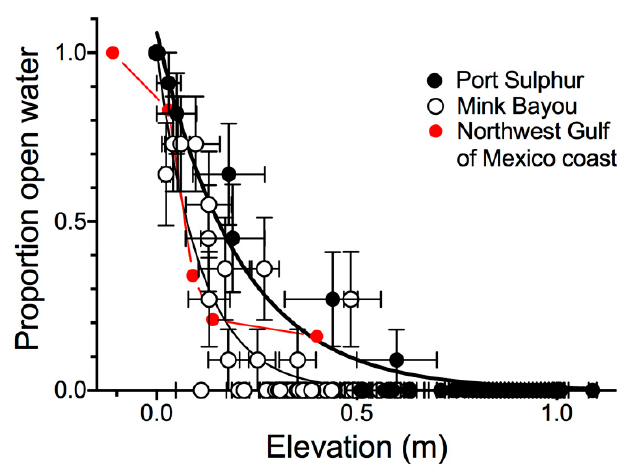
Figure 5. The proportion of open water and elevation ( ± 1 SEM) between 75 to 125 m distance from the land–water interface. A hyperbolic fit of the data is shown. The red line is for a Spartina patens marsh on the Northwest Gulf of Mexico coast [34].